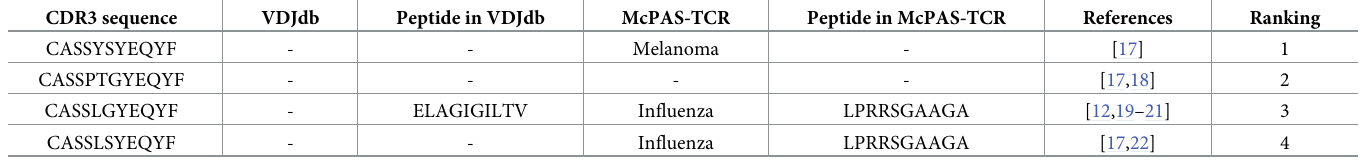
Table 1. CDR3 sequences that show cross-species, tumor-Exclusive, behaviors. CDR3